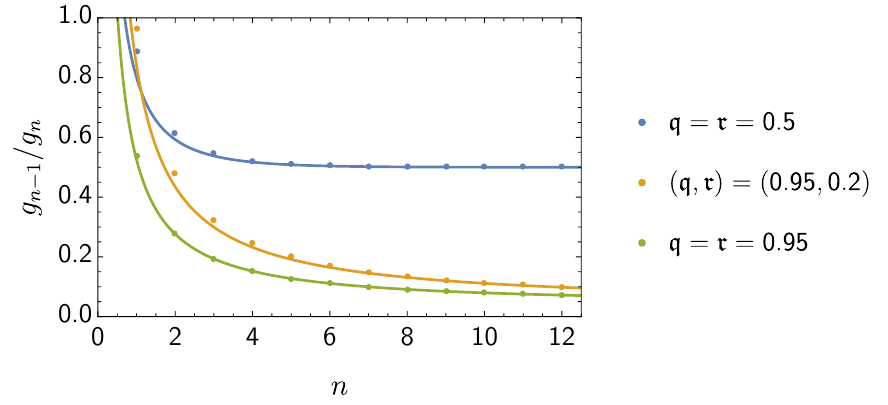
Figure 10 . Ratio of the inner product g n − 1 /g n = h n − 1 , n | n − 1 , n i / h n, n | n, n i . The dots are computed by numerically solving the recursion relation (3.3). The solid lines are given by the approximation (3.6). As q , r → 1 − , the approximation holds everywhere. For finite values q , r < 1 , the approximation holds for large n